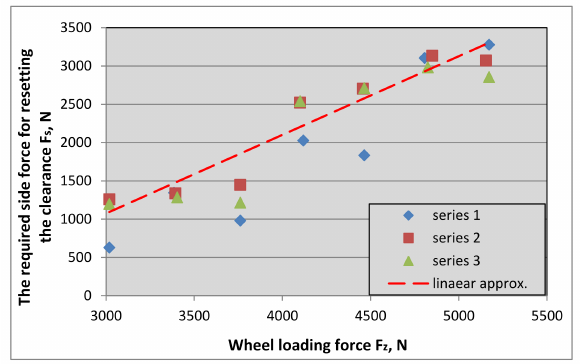
Figure 8. Characteristics of resetting the rocker arm